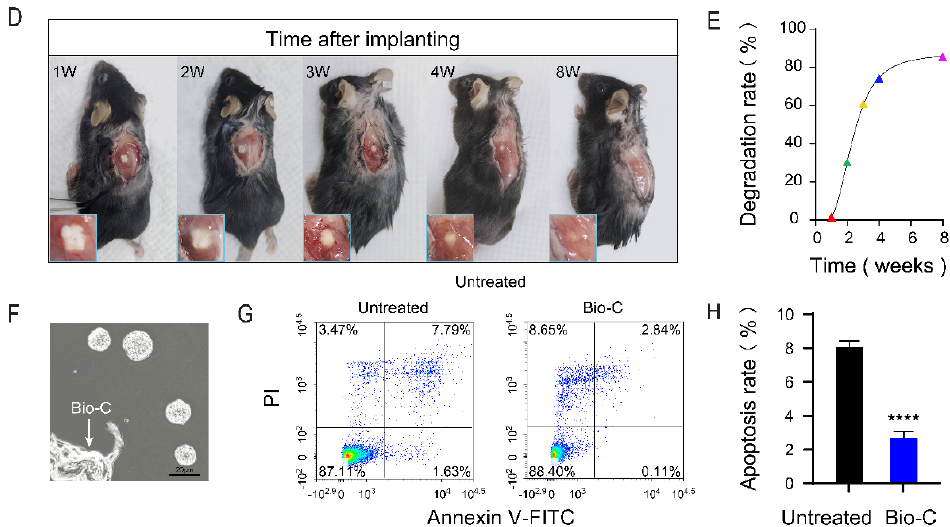
Figure 1. Characterization of Bio-C. ( A ) Schematic representation of Bio-C construction. (Step1) Bio-C constructed by the acid-desalted-collagen (ADC) and two outer HMW-HA layers. (Step 2) surface modification of purified ADC, using pre-crossed HMW-HA/and hydrated HMW sodium hyaluronate mixture to form first layer. (Step 3) Deposition of second layers of hydrated HMW sodium hyaluronate. ( B ) Electron micrographs of Bio-C scaffolds. TEM image showing ADC fiber at the core of Bio-C, maintaining collagen fibril structural integrity by periodic stripes with alternating light and dark shades (left). SEM image showing the morphology of Bio-C in sagittal plane and coronal plane (middle and right). ( C ) Statistical diagram showing the range of average pore diameters (arrow in B ) from five batches of Bio-C. Over 70% of the samples carrying averaged pore sizes ranging between 3 and 5 μ m. ( D ) Biodegradation and biocompatibility of Bio-C in vivo. Animals with Bio-C implants demonstrating different levels of material degradation from 1 week to 8 weeks. Enlarged images demonstrating mice with Bio-C implantations in the back muscle did not show signs of tissue rejection. ( E ) Degradation curve of Bio-C in vivo. The diagram revealed degradation kinetics of Bio-C from less than 10% at 1 week to over 85% at 8 weeks. ( F ) Morphology of neurospheres cultured in the presence of Bio-C. ( G ) NSCs apoptosis rates detected by PI/FITC-annexin V along combining with flow cytometric analysis. ( H ) Statistical diagram showing NSCs apoptosis rates with or without Bio-C. (**** p < 0.0001 significantly different from untreated control. Unpaired t -test. Data are presented as the mean ± SD.)